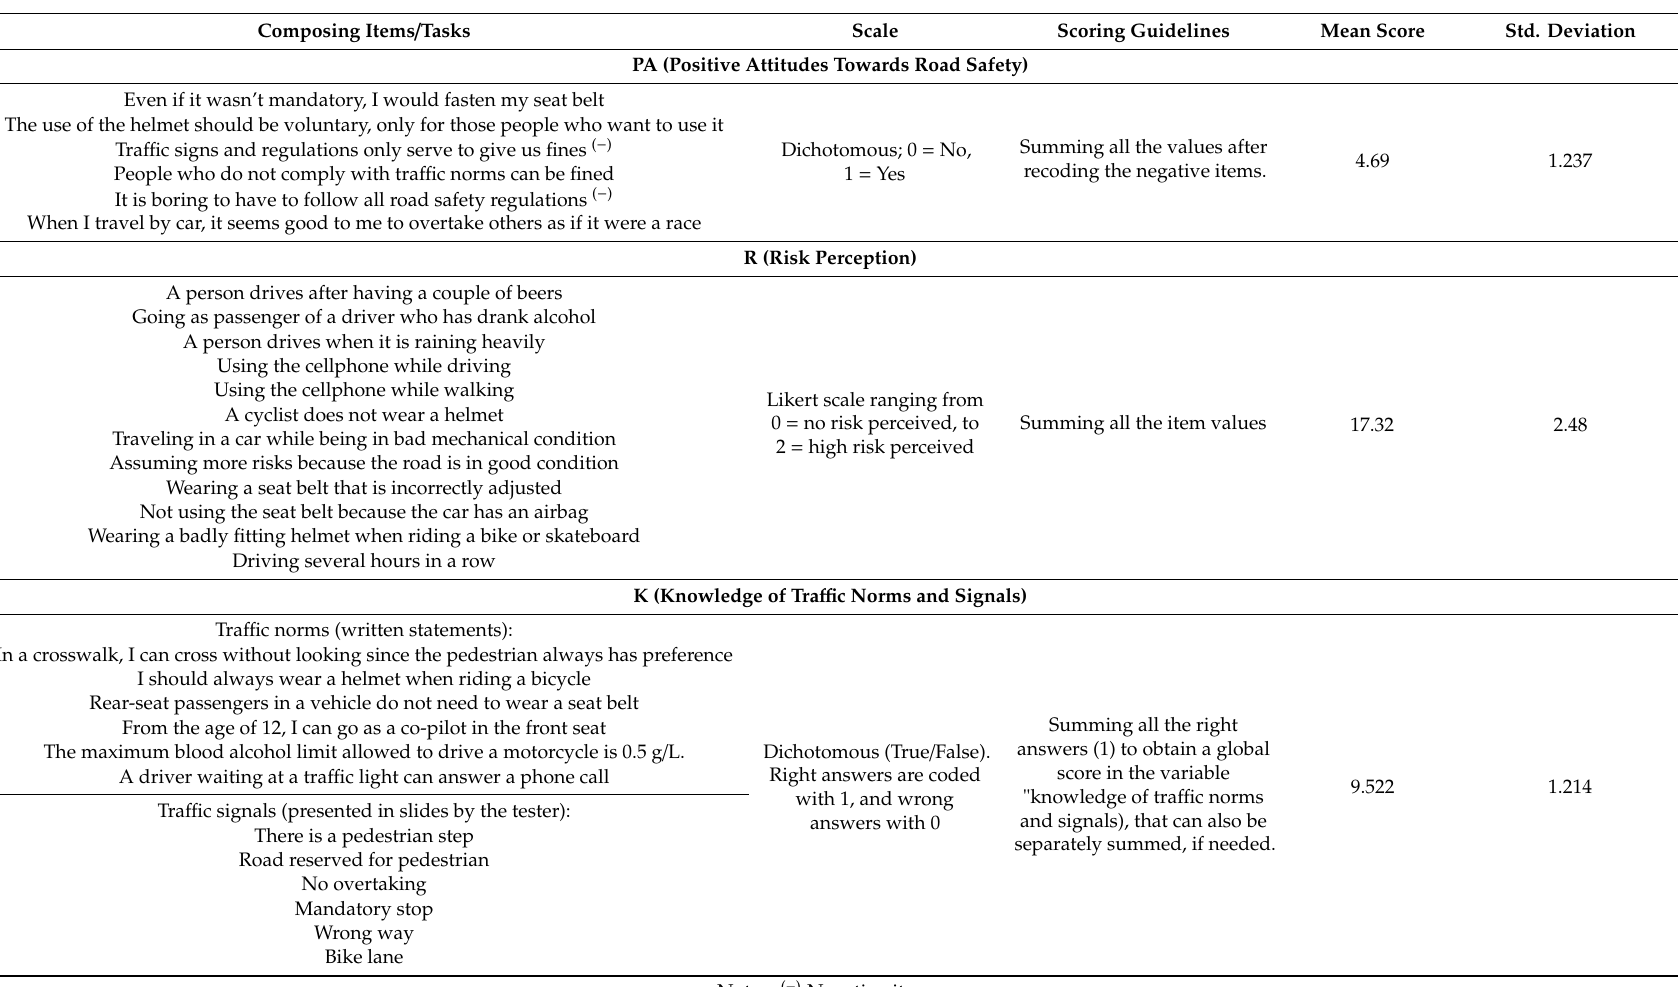
Table 1. Composition of the scales measuring the three skills of the positive attitudes, risk perception and rule knowledge (PARK) model. Composing Items /